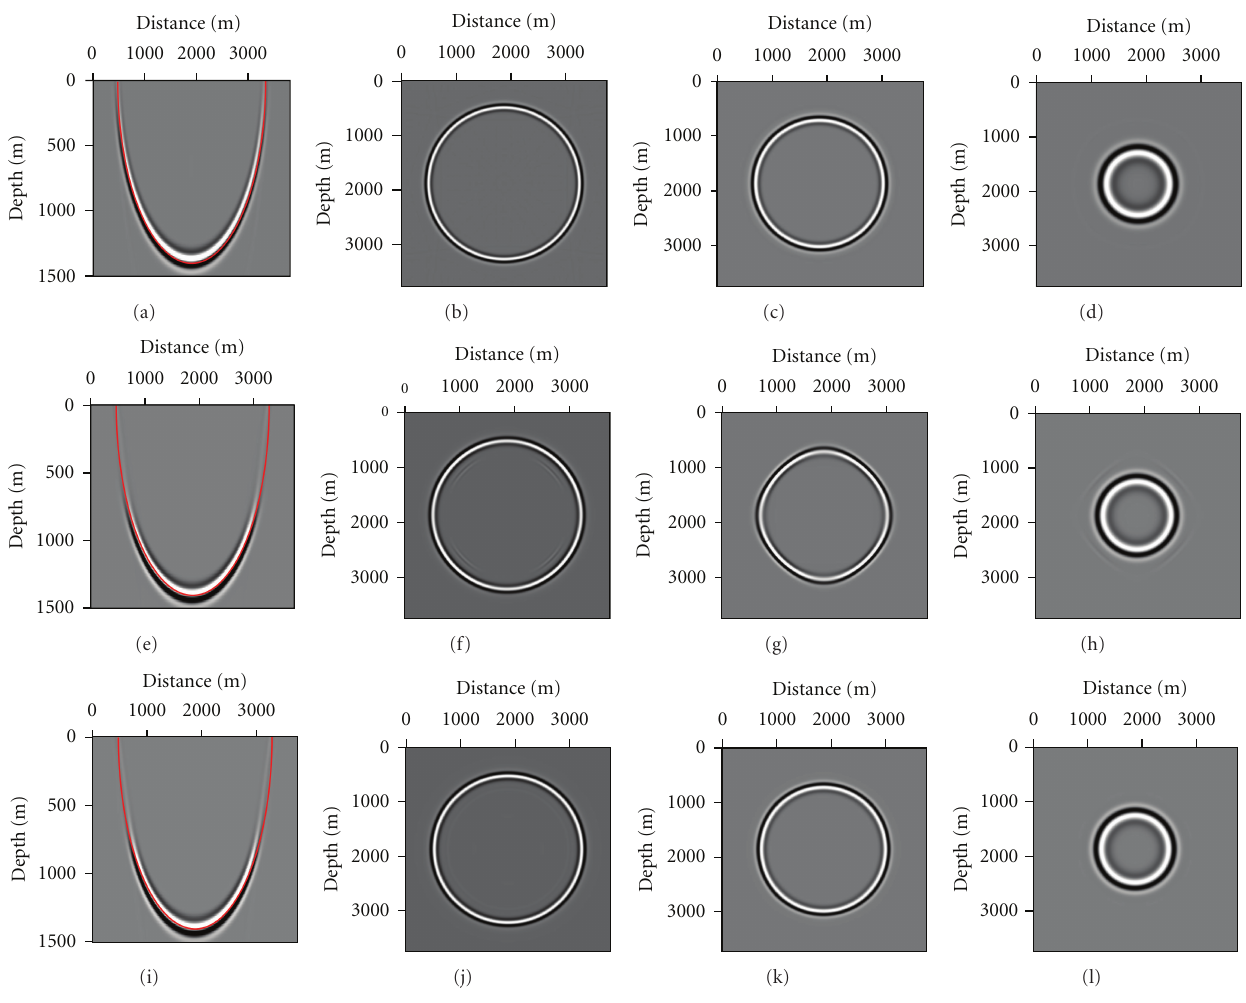
Figure 1: Migration impulse responses. (a)–(d): reference result by phase-shift migration using the true medium velocity. (e)–(h): FFD migration using conventional two-way splitting; p = 0 . 75. (i)–(l): FFD migration using conventional four-way splitting; p = 0 . 75. From left to right: central vertical cut in the x - z plane and horizontal cuts at 150m, 750 m, and 1250 m depth.